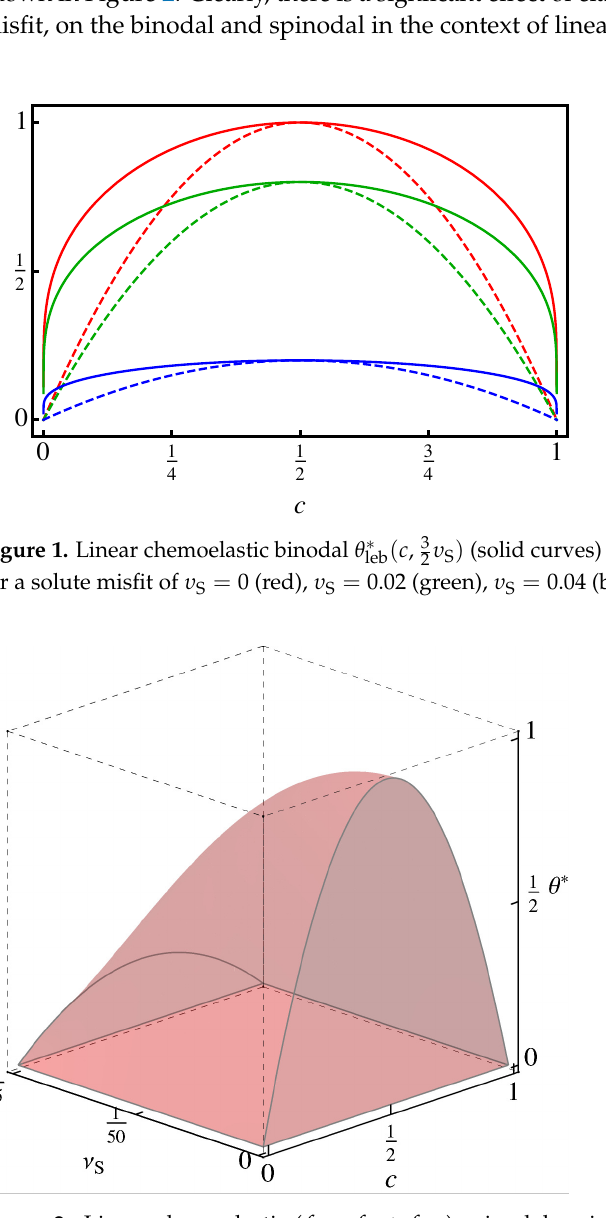
Figure 2. Linear chemoelastic ( f = f le + f CH ) spinodal region ∂ 2 c f < 0 and surface ∂ 2 c f = 0 in composition c , solute misfit υ S , normalized temperature θ ∗ , space for v m k el / w AB = 10 3